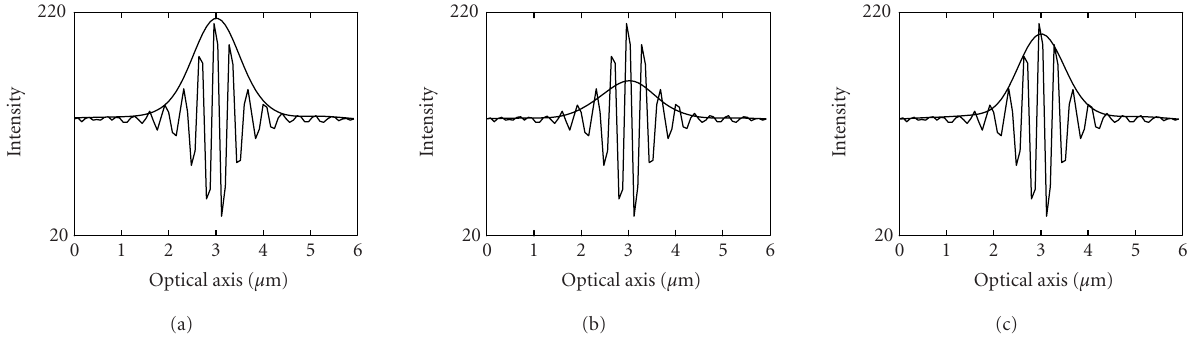
Figure 4: Profile with splines: (a) ( k , m ) = (0,1); (b) ( k , m ) = (2,2); and (c) ( k , m ) = (2,3).